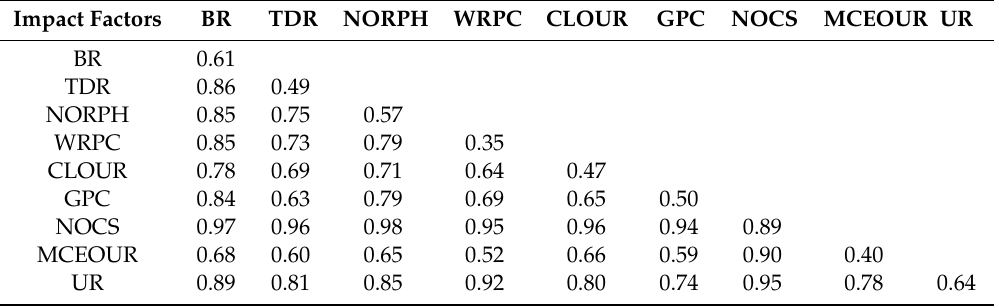
Table 8. PD values for interactions between factors on the